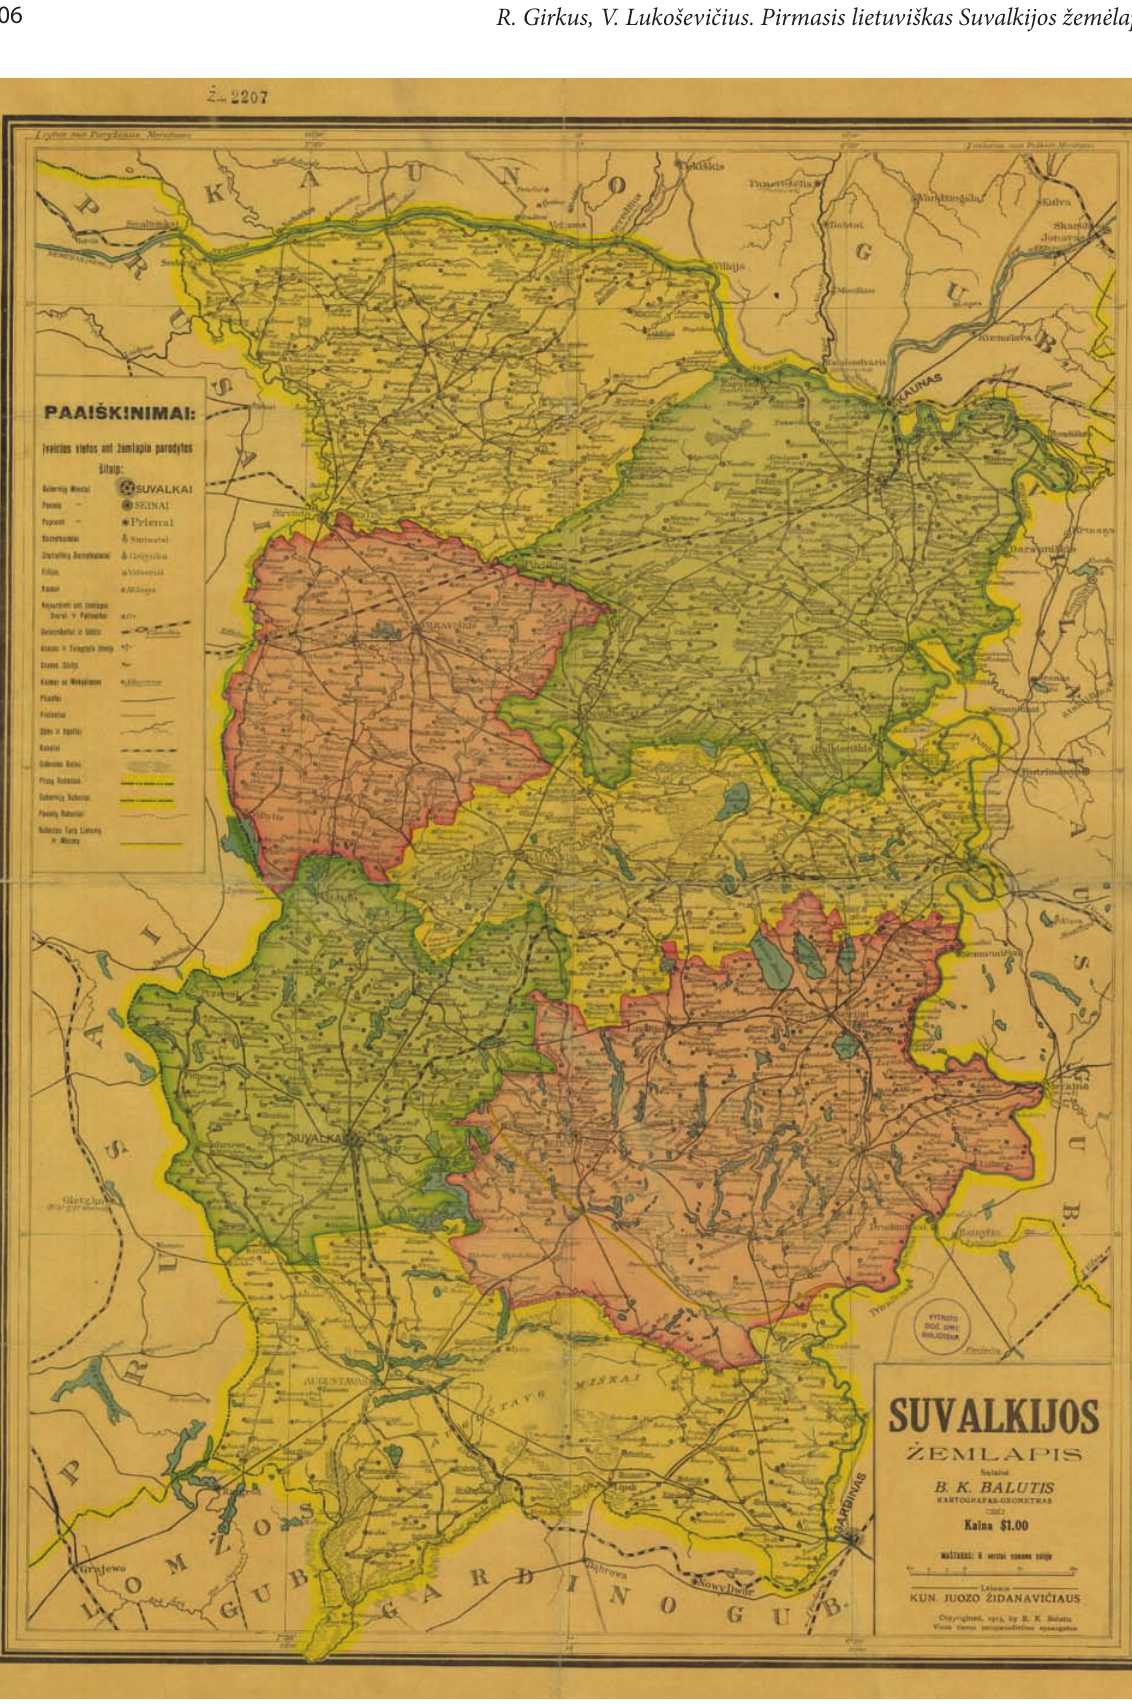
Fig. 3 . Suvalkija map of B. K. Balutis, scale 1:252 000,